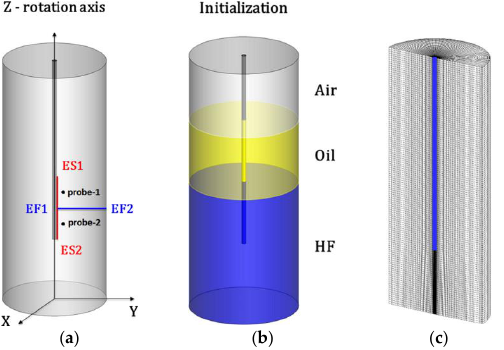
Figure 2. ( a ) Positions of reference system and data extraction lines on the 3D fluid model of the experimental test case (EF1-EF2 used for fluid velocity data, ES1-ES2 used for fiber stress data); ( b ) Initial configuration: the three stratified fluids are respectively HF, oil, and air; ( c ) Numerical grid. No turbulent closure models have been chosen due to the low inner- and outer-cylinder Reynolds numbers considered, as discussed previously. The counter-rotating movement of fiber and vial is obtained by means of moving walls. The tangential velocities corresponding to the rigid motion of fiber and vial along to their axes have been imposed as boundary conditions on the walls, which are treated as no-slip boundaries. Therefore, at the wall, the flow has zero axial and radial velocity, while it is characterized by a tangential velocity component in the absolute frame of reference. Time-dependent wall velocities have been assigned in ANSYS ® Fluent ® by means of User’s Defined Functions (UDF). In terms of model assessment, three different levels of simulations with increasing model accuracy have been tested for both swirling cases in order to understand the effects of model characteristics on the results. The base level, referred to as MOD1, does not account for surface tension (ST) and wall adhesion (WA). The second level, referred to as MOD2, accounts only for surface tension via the Continuum Surface Force method (CSF) of Brackbill et al. [19]. The third one, referred to as MOD3, accounts for both surface tension (via CSF method) and wall adhesion (WA). A value of 0.047 N/m has been set for the surface tension at the HF-oil interface while the static value of the adhesion angle at the fiber has been set at 17° in the HF domain [20]. Table 1 shows the simulation matrix with geometrical features, operating conditions and selected numerical models. Simulations have been started at rest conditions, with initialization conditions shown in Figure 2b, and accelerated through a one-second numerical transient to reach the nominal rotational regime. The time step has been chosen as a fraction of the revolution period of the fiber in the TCN2 case. A preliminary analysis has been initially performed on MOD1 considering three different time steps equal to 1/100, 1/10 and equal to the period itself. No remarkable differences have been detected for the three cases, thus allowing the selection of a time step equal to the fiber revolution period (0.01 s). It can be underlined that a lower time step has also been selected as a function of the numerical setup, as reported in Table 1. In fact, in order to decrease the intensity of spurious currents, which are characteristics of the available surface tension models, the time step in tests 03, 04, 05, and 06 has been reduced to 10 −5 s. Good results have been accomplished for model MOD2 almost reaching the suppression of the spurious currents while MOD3 resulted to be yet affected although with a reduced parasitic currents intensity.